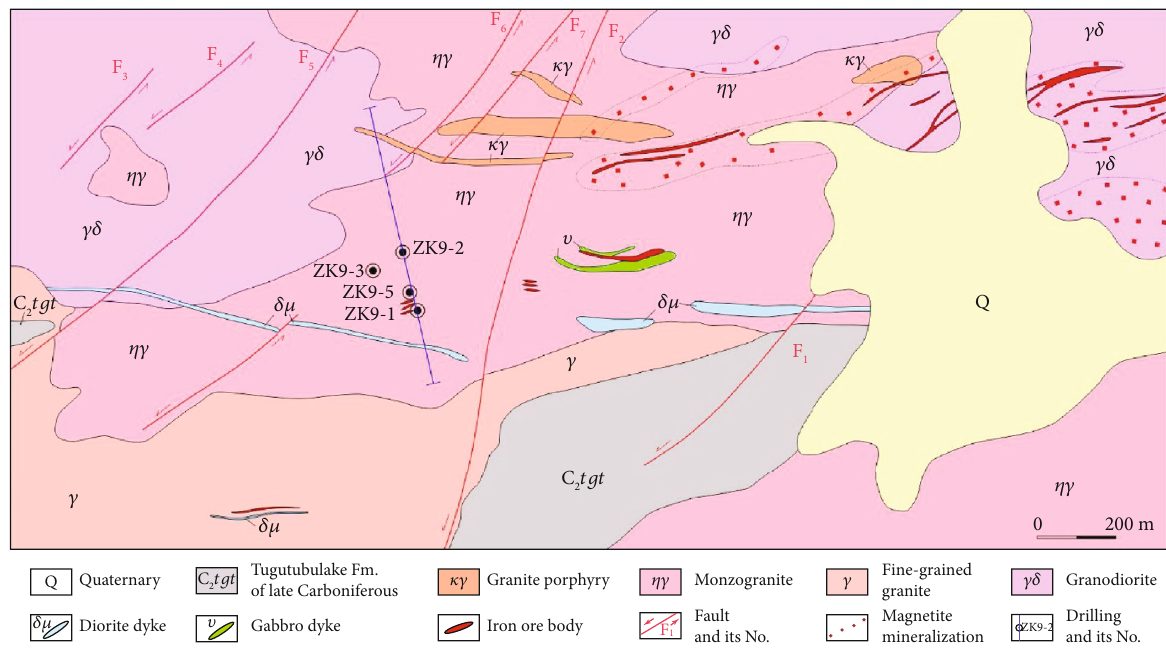
Figure 2: Simpli fi ed geological map of the Tieling Cu-Mo deposit (modi fi ed from Geological Survey Academy of Xinjiang, 2008).